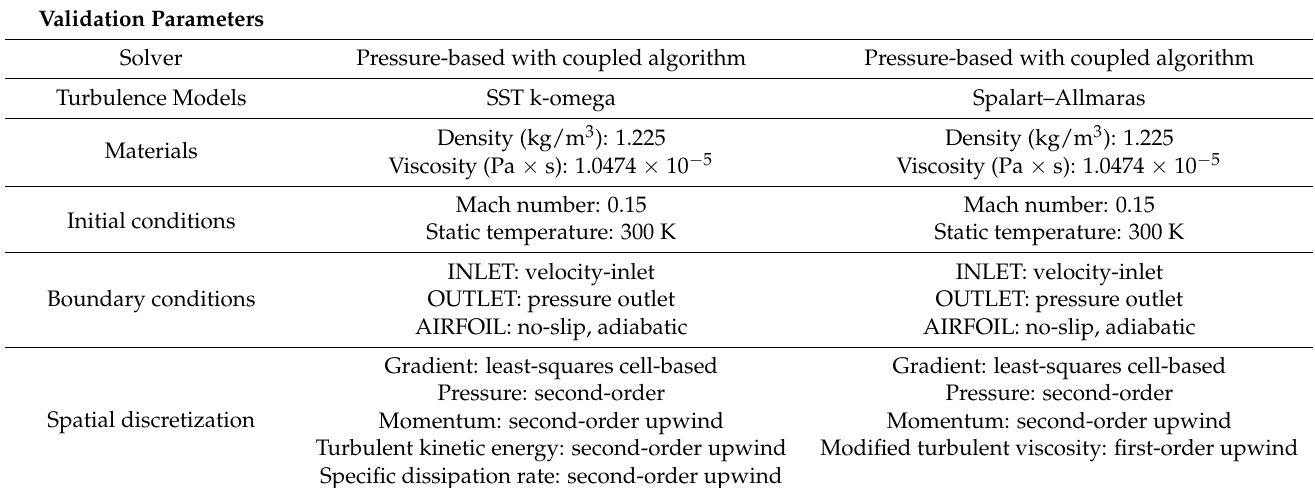
Table 4. Simulation parameters of convergence numerical